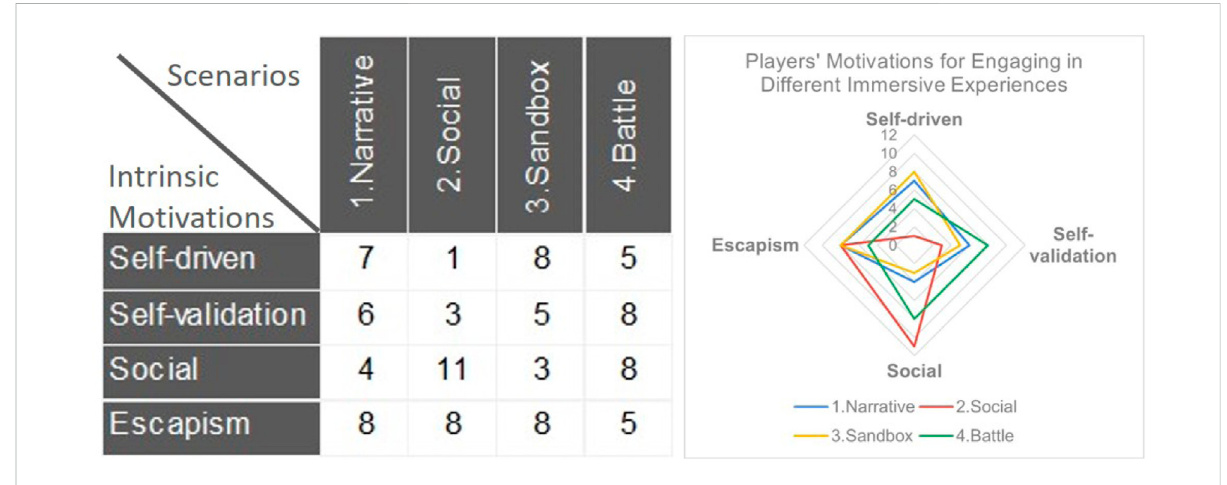
FIGURE 4 Participants ’ intrinsic motivations for engaging in the four scenarios in